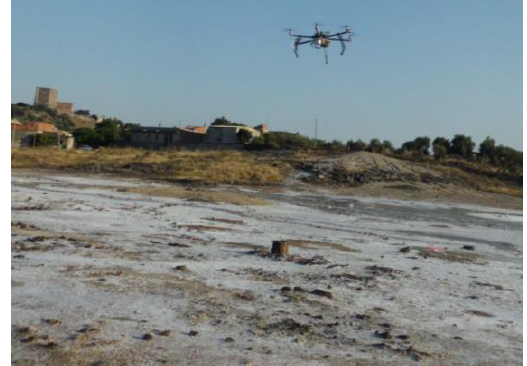
Figure 5. Visible image of the investigated area.t The white surface is due to the presence of salt deposit while the darker are the muddy.